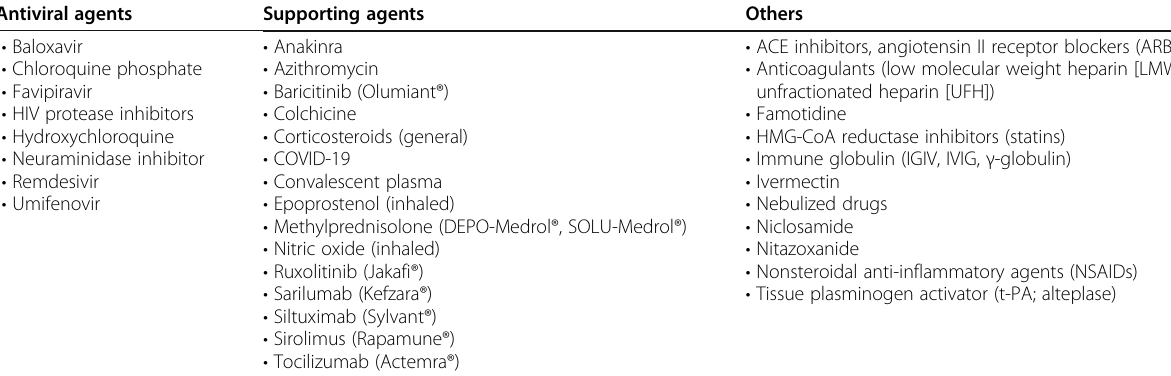
Table 5 Supporting agents used in treatment Antiviral agents Supporting agents